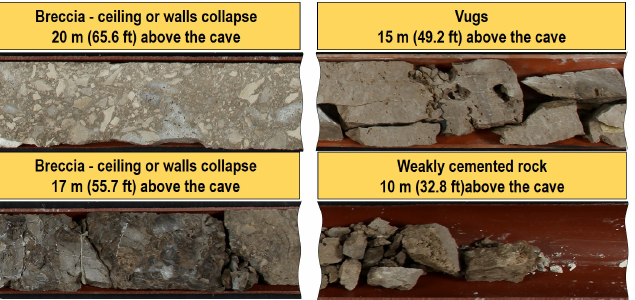
Figure 5. Core-samples photos of the interval preceding the cave (Well #1)